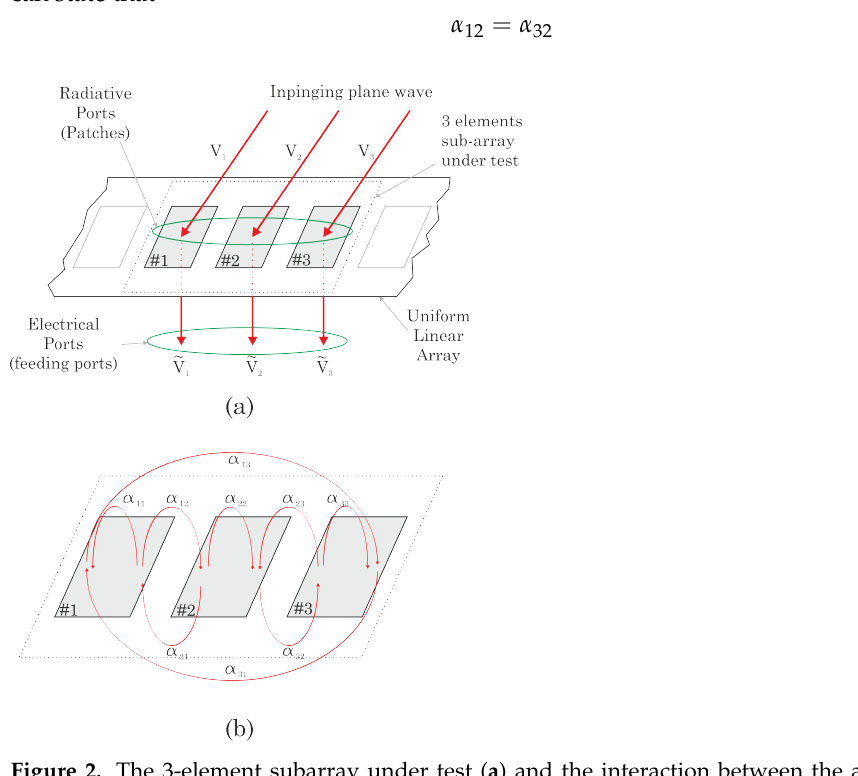
Figure 2. The 3-element subarray under test ( a ) and the interaction between the antenna array elements considered in the model ( b